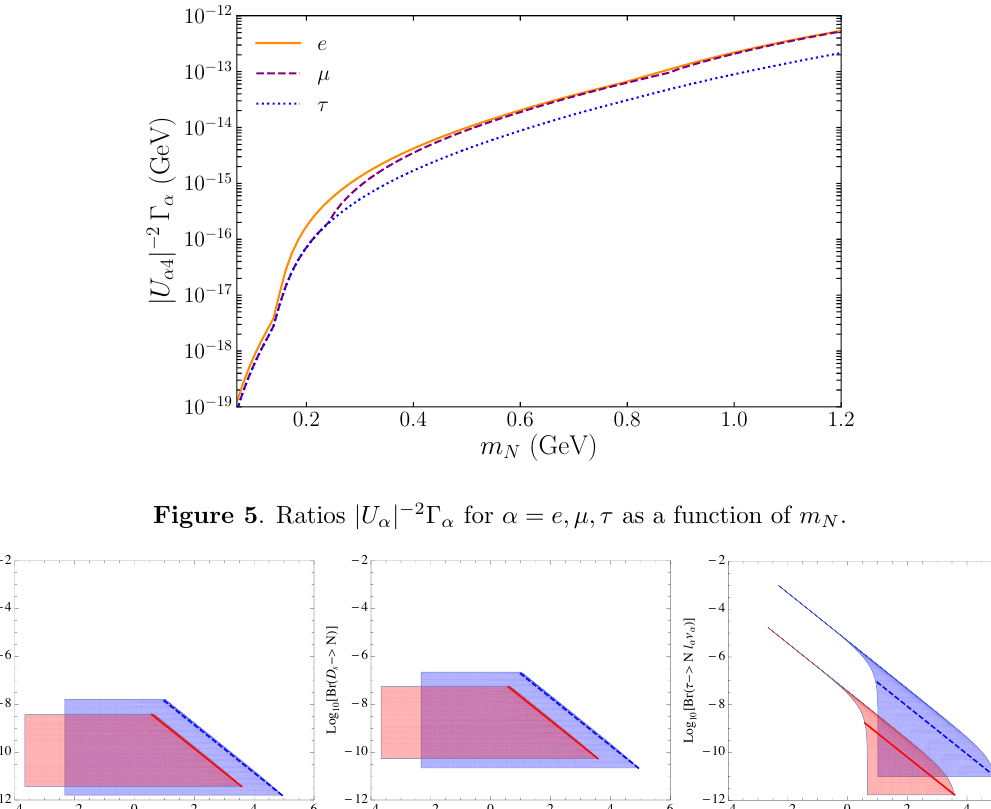
! N ) (middle panel) and ( s )